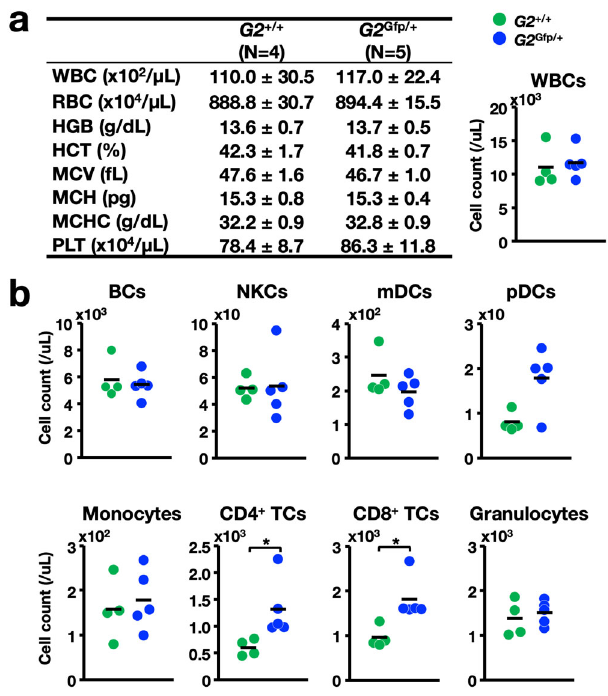
Fig. 5 Evaluation of the peripheral blood counts of G2 Gfp/ + mice at 6-7 months old. a Summary of hematopoietic indices. A dot plot of WBC counts in the peripheral blood of G2 + / + and G2 R398W/ + mice and their G2 + / + littermates is shown in the right panel. b Dot plots of the cell count of the indicated cell population in the peripheral blood of G2 + / + and G2 R398W/ + mice. * p < 0.05, N = 4 – 5 of each